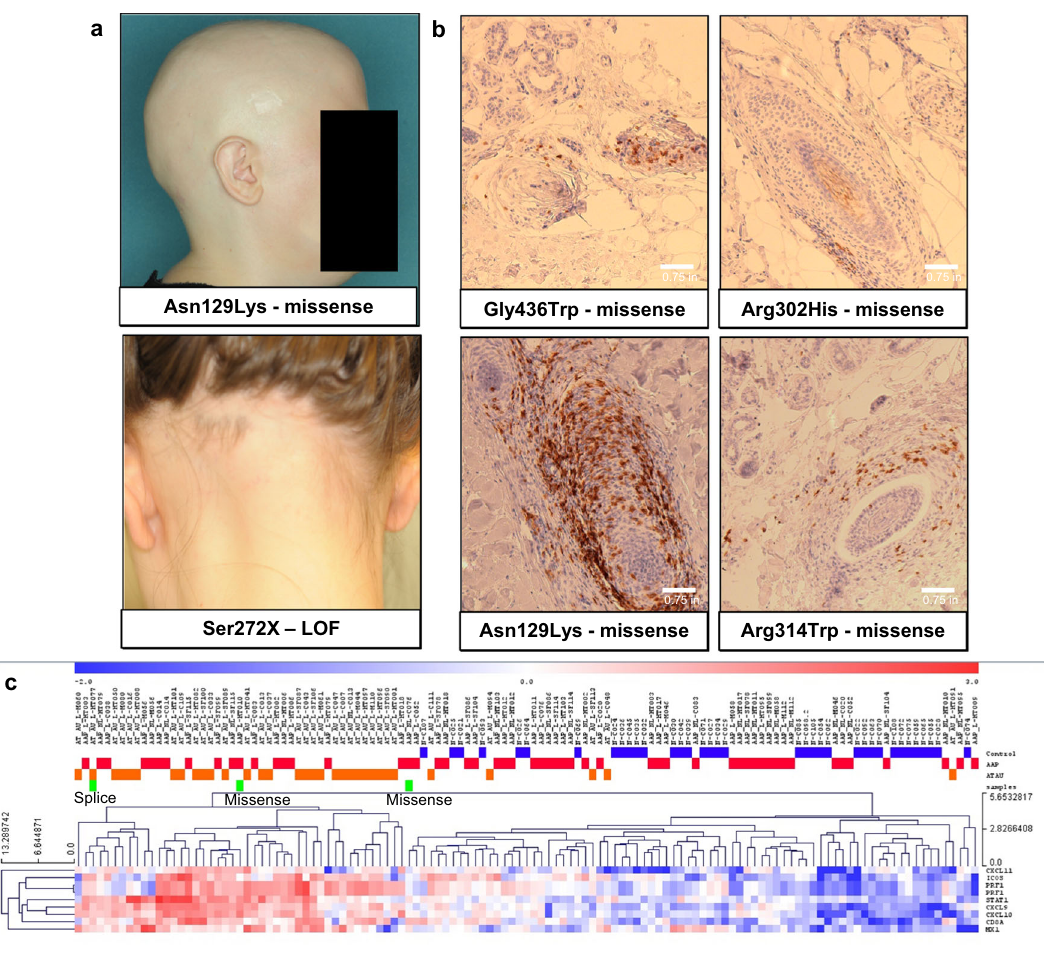
Fig. 3 Patients with KRT82 variants con fi rmed to have AA. a Clinical photos of two patients with a missense and nonsense (LOF) variant in KRT82, respectively. Both show hair loss patterns characteristic of AA. b Immunohistochemistry (IHC) staining of CD8 + T cells in 4 patients with missense variants in KRT82 . Perifollicular CD8 + T cell in fi ltrate is a diagnostic characteristic of AA. Each biopsy shown is taken from an individual with AA, serving as 4 biological replicates. c RNA expression pro fi les of the ALADIN (Alopecia Areata Disease Severity Index) in fl ammatory signature con fi rms that three patients (green bars) with KRT82 variants (splice and missense) have increased expression of the in fl ammatory signature, characteristic of AA. Additionally, these three KRT82-carrying patients (green) cluster within AA patients (AAP-red, ATAU-orange), and not with controls (blue).